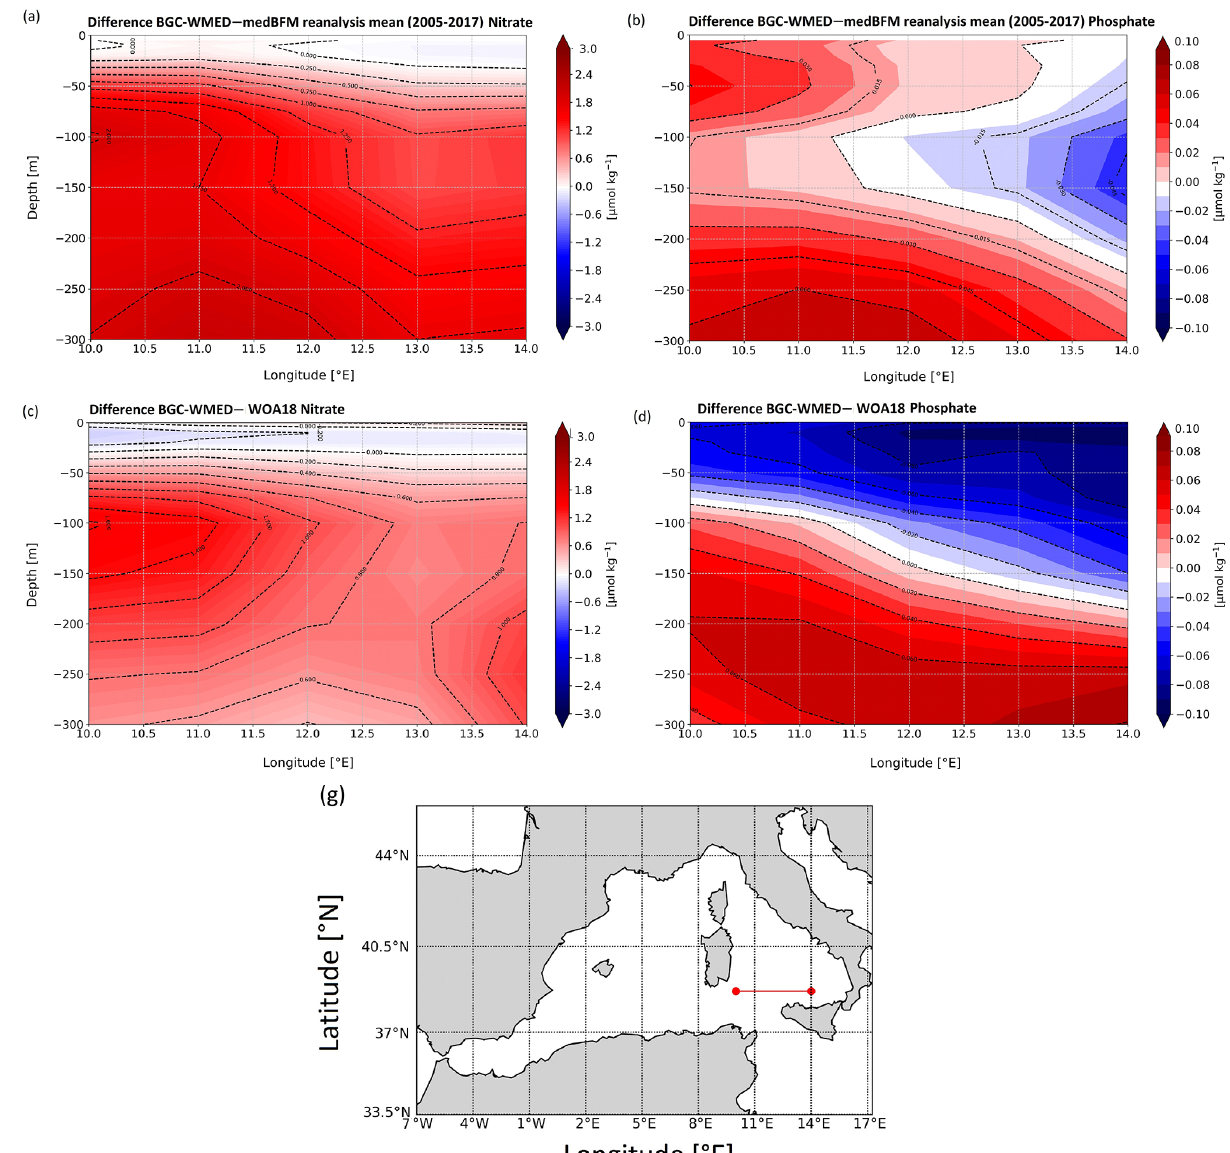
Figure 18. Same as Fig. 17 but for the vertical section from the Tyrrhenian Sea.